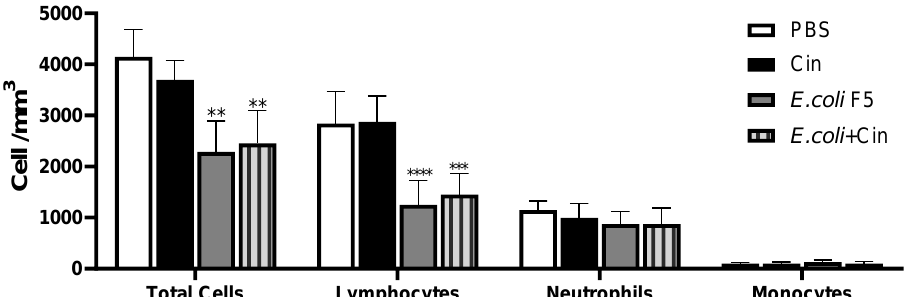
Figure 4. Total and differential blood cell counts from animals infected with E. coli F5 and cinnamal- dehyde treatment. Ten hours after peritoneal inoculation of E. coli F5, blood samples were collected for total and differential cell counting. The results represent the mean ± S.D. of 6 animals/group. ** p < 0.01 as compared with the PBS group, *** p < 0.001 as compared with the PBS group, and **** p < 0.0001 as compared with the PBS group.